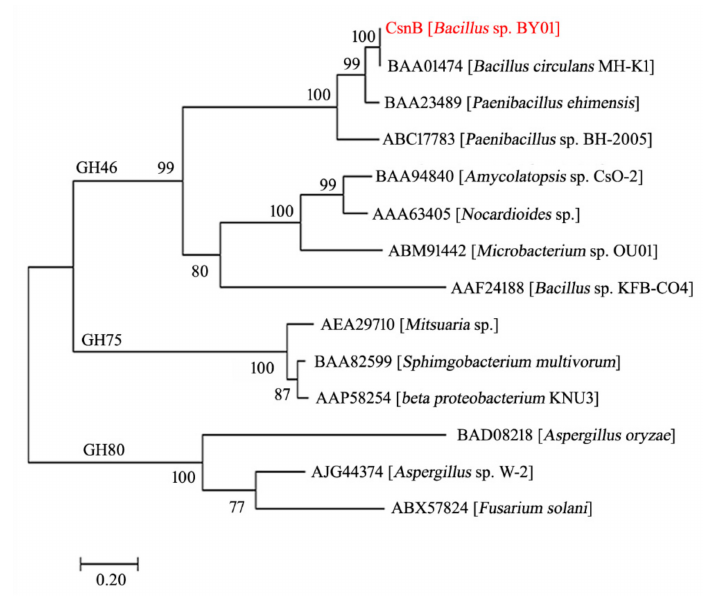
Figure 1. Phylogenetic analysis of CsnB and other chitosanases. The neighbor-joining tree indicates phylogenetic relationships between CsnB and other GH family 46, 75, and 80 members. The scale bar indicates the average number of amino acid substitutions per site. The bootstrap test of the tree was performed with 1000 replications.